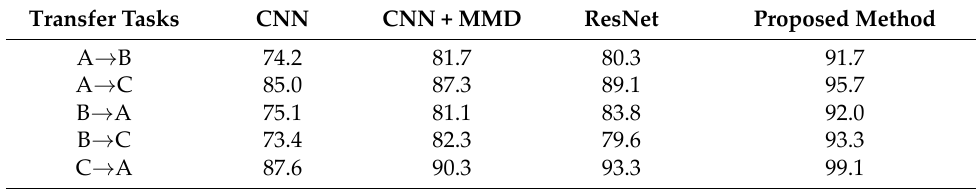
Table 6. Classification accuracy of all methods (%).